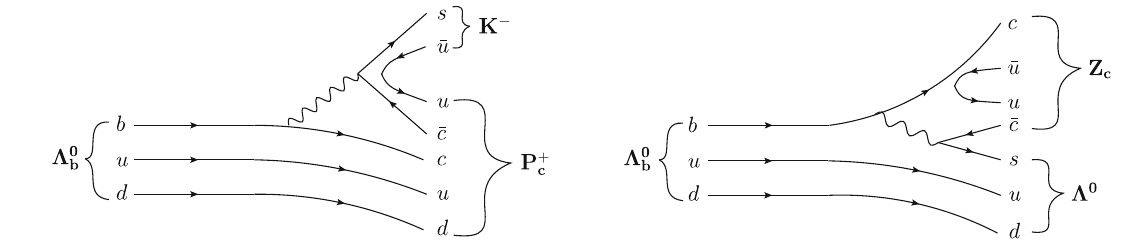
Fig. 1 Feynman diagrams contribute to (cid:2) 0